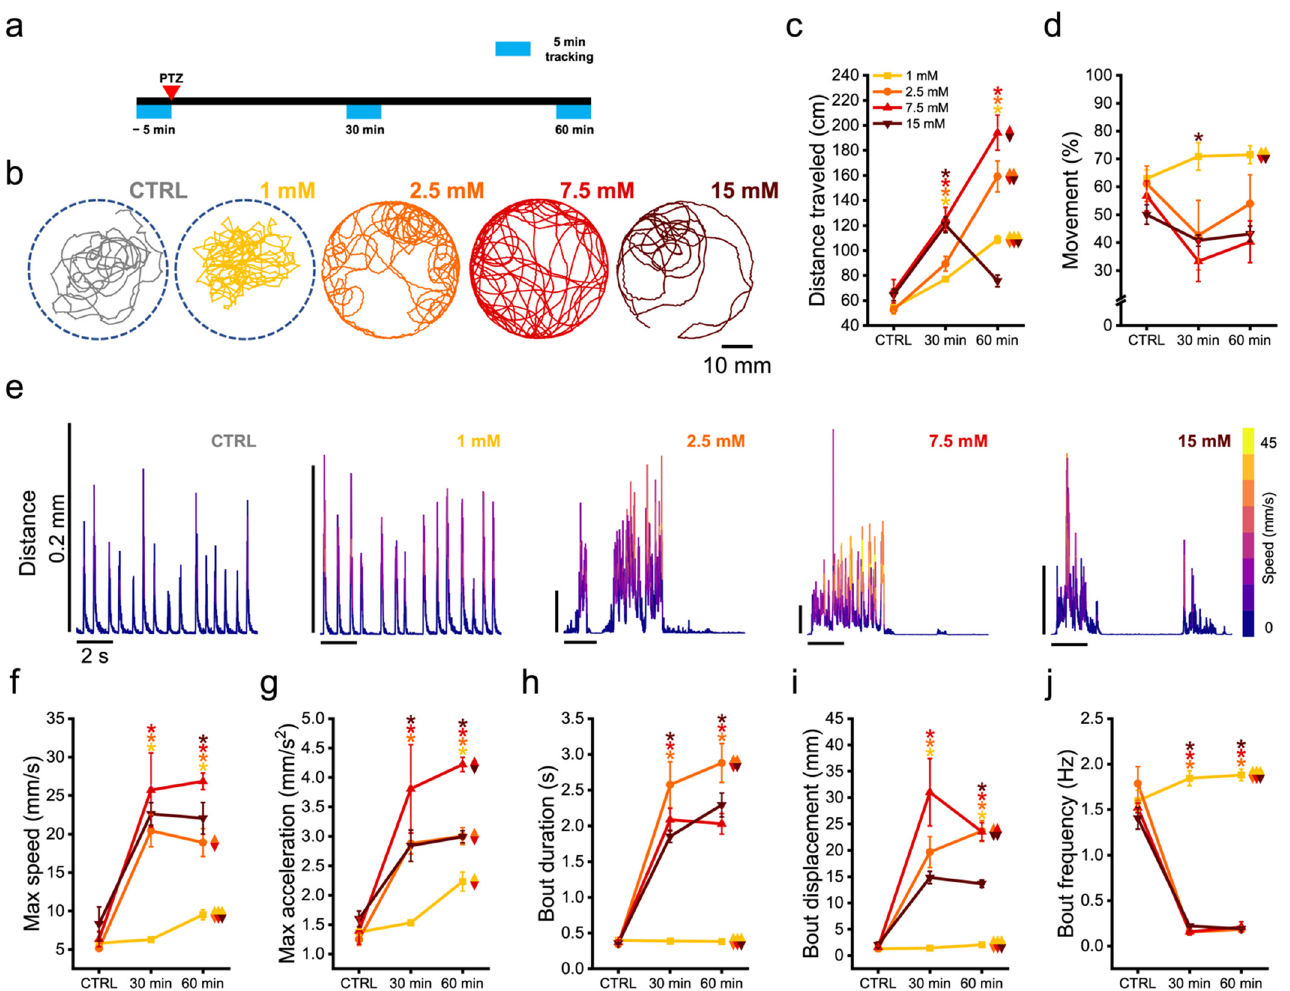
Figure 3. Zebrafish larvae undergo alteration of their swimming kinematic during seizures. ( a ) Scheme representing the behavioral tracking protocol adopted. The larvae were tracked along 5 min before the exposure to PTZ and 30–60 min after. ( b ) Swimming trajectories over 5 min of behavioral recording of one larva for each of the following conditions: pre-exposure (CTRL) and 60 min after the exposure to the different PTZ concentrations. ( c , d ) Average total distance traveled ( c ) and percentage of time spent in movement ( d ) in 5 min recording in the 3 different tracking windows (CTRL, 30 and 60 min), in larvae exposed to one of the four PTZ concentrations tested (see legend for colors). ( e ) Representative swimming bout shapes observed in each of the conditions reported, presented as larval displacement over time. Traces are color-mapped according to swimming velocity (warmer colors higher speed). ( f – j ) Average kinematic features of swimming bouts -maximum speed ( f ), maximum acceleration ( g ), duration ( h ), displacement ( i ) and frequency ( j )—during 5-min recording epochs before PTZ exposure and 30–60 min after. * indicates p -value < 0.05 for intra-group comparison with respect to control (CTRL) values, one-way repeated measures ANOVA and post hoc Tukey’s test (for p -values see Table S6). Diamond symbol indicates p -value < 0.05 for inter-group comparison at 60 min exposure, two-way repeated measures ANOVA and post hoc Tukey’s test (for p -values see Table S7). Color couples in each symbol indicate groups compared. Values represent mean ± s.e.m. of n = 4 larvae per concentration.